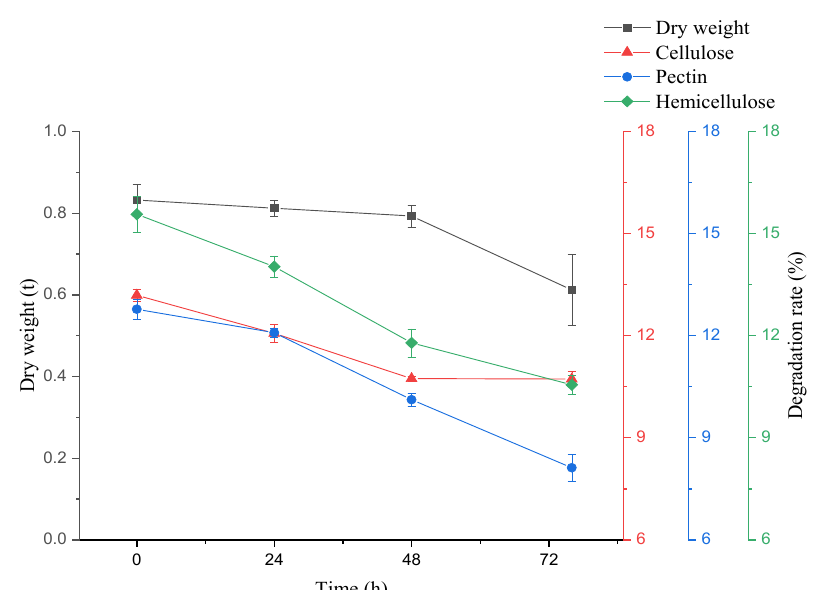
Figure 2. Component changes of wastewater composition. Error bars show a standard error from triplicate observations.